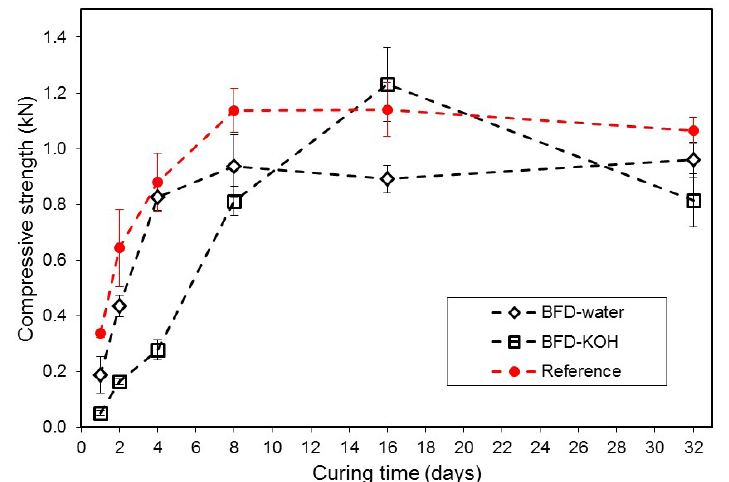
Figure 7. The average compressive strength of 3 wt% sodium silicate-3 wt% BFD-water or 2 M KOH pellets air-dried for up to 32